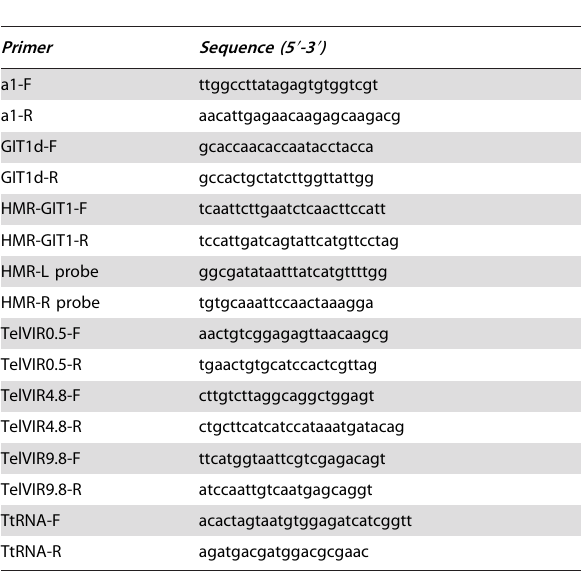
Table 3. Oligonucleotides used in this study.